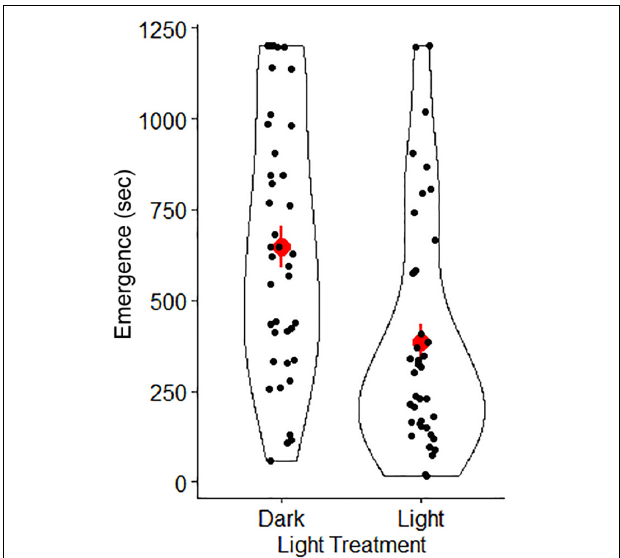
FIGURE 5 | Mean (red points) ± SE (red lineranges) of emergence time for Australian house geckos ( Gehyra dubia ) in two light treatments. Black points represent the distribution of data. The dark treatment was completed at 0.0007 lux, representing the darkest nights (e.g., new moon conditions = 0.0022 lux). The light treatment was completed at 0.0091 lux and had low ambient light levels from a partially concealed light bulb in the corner of the testing room to represent the brightest nights (e.g., full moon conditions = 0.0230